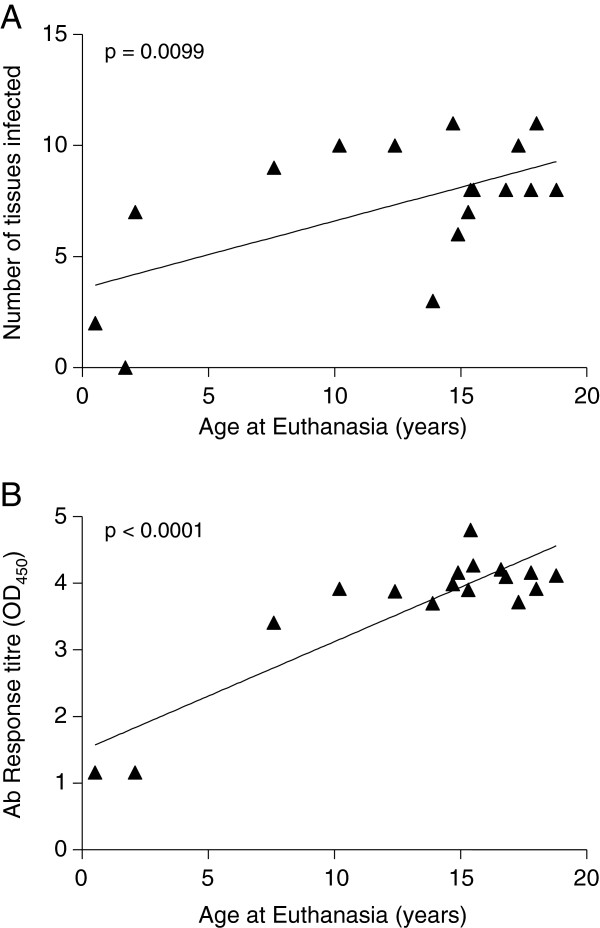
Correlation between (A) the number of tissues positive for SFV provirus and age and (B) the antibody titre and age.